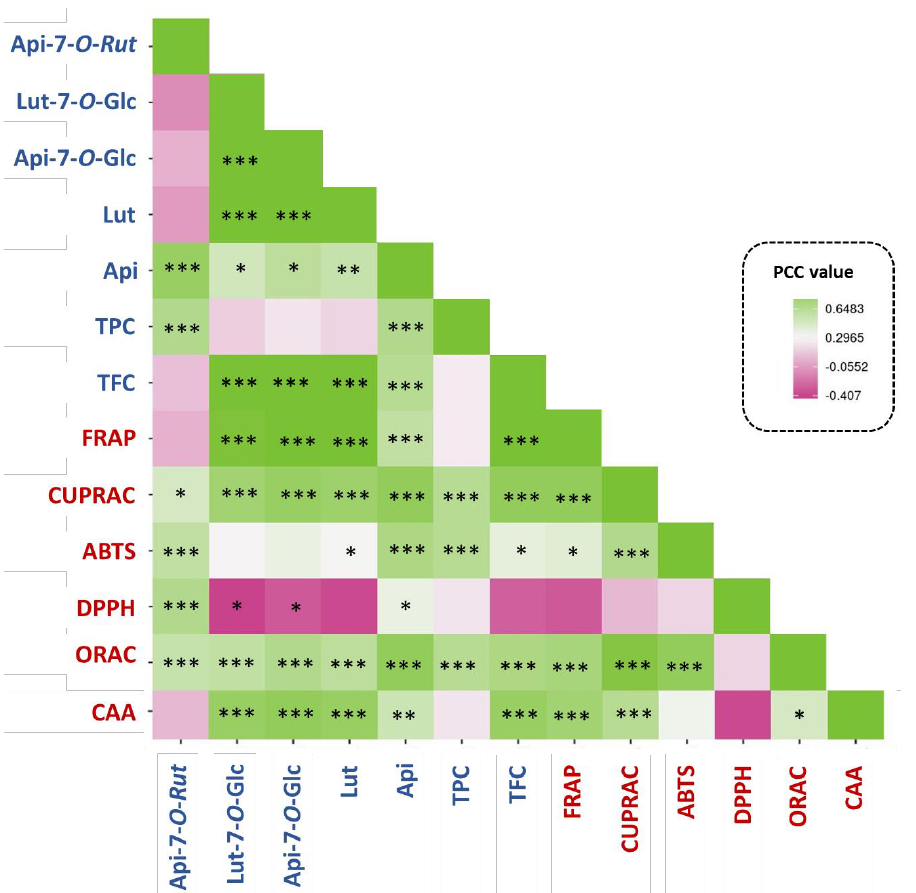
Figure 9. Pearson coefficient correlation (correlogram analysis) between the phytochemical profiles and antioxidant activity of extracts. Api-7- O -Rut: apigenin-7- O -rutinoside; Lut-7- O -Glc: luteolin-7- O -glucoside; Api-7- O -Glc: apigenin-7- O -glucoside (also known as apigetrin); Lut: luteolin; Api: apigenin; TPC: total phenolic content; TFC: total flavonoid content; ABTS: 2,2-azinobis (3- ethylbenzthiazoline-6-sulphonic acid); DPPH: 2,2-diphenyl-1-picrylhydrazyl; FRAP: ferric reducing antioxidant power; CUPRAC: cupric reducing antioxidant capacity; ORAC: oxygen radical absorb- ance capacity; CAA: cellular antioxidant assay. *** significant p < 0.001; ** significant p < 0.01; * sig- nificant p < 0.05; PCC values are indicated in Table S3.